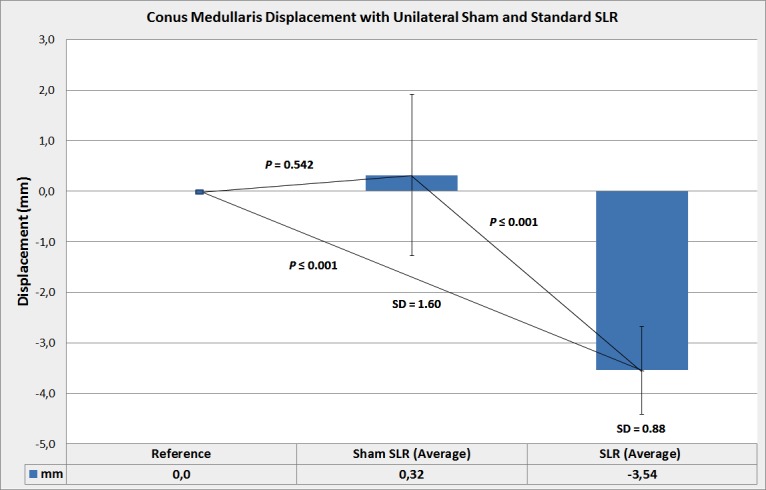
Conus medullaris displacement with unilateral Sham SLR and standard SLR.Mean value and standard deviations of measurements are presented. Values are expressed as positive or negative to indicate respectively proximal or caudal direction of conus medullaris displacement. Even if the average value indicates mean conus displacement in response to a Sham SLR as proximal, the conus displaced in both proximal and distal direction. This showed to be consistent in terms of direction and magnitude within subjects, but not between subjects.